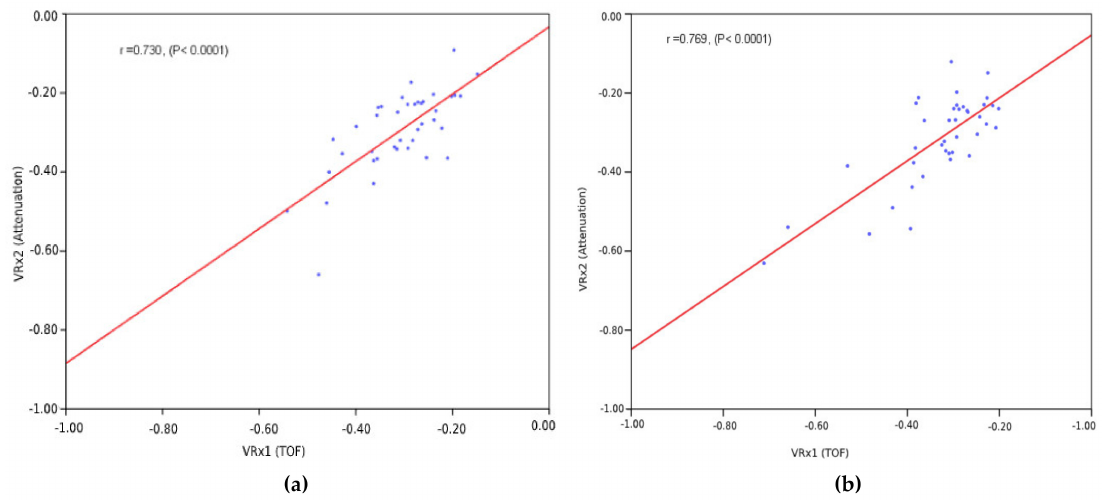
Figure 6. Comparison of VRx1 and VRx2 indices by regression analysis. ( a ) Bandpass filtering. The correlation coe ffi cient between VRx1 and VRx2 indices is denoted as r = 0.730. The statistical significance is p < 0.0001. ( b ) FIR filtering. The correlation coe ffi cient between VRx1 and VRx2 indices is r = 0.769. The statistical significance is p < 0.0001.